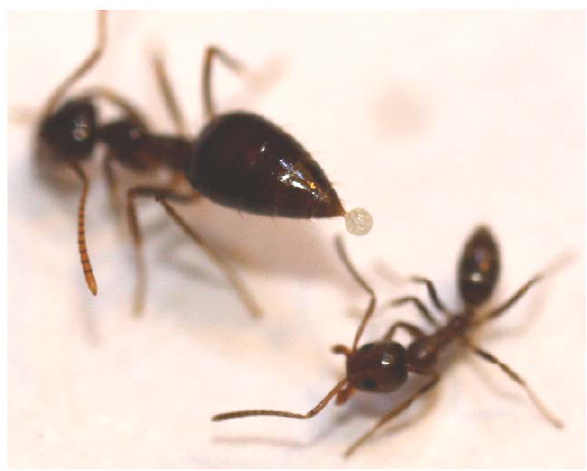
Figure 1. The P.imparis secretion. A single P. imparis worker is shown with a liquid droplet containing bubbles at the tip of its raised abdomen. The secretion is then applied to the body of the L. humile ant.